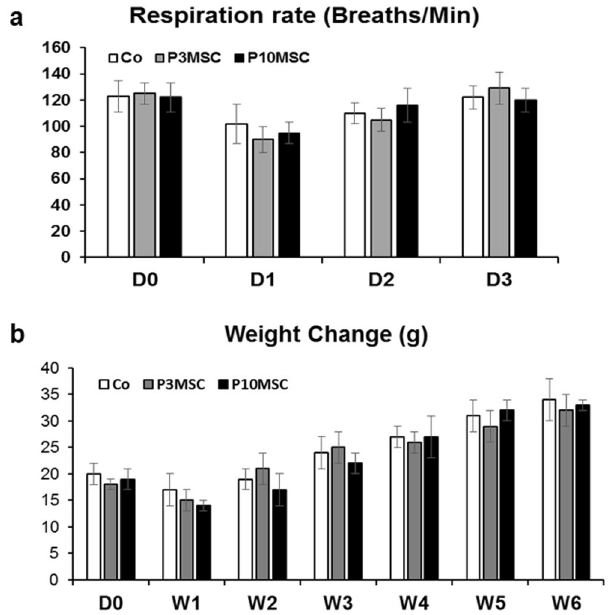
Figure 3. Gross observations before and after mouse allograft surgery. ( a ) Respiration rates were measured by visually counting the number of chest movements per minute (breaths/min) (n = 6) at day 0 (D0), day 1(D1), day 2(D2), and day 3(D3). ( b ) Values represent the weight change compared with the starting weight (D0) before surgery and after surgery at week 1 (W1), week 2 (W2), week 3 (W3), week 4 (W4), week 5 (W5), week 6 (W6).